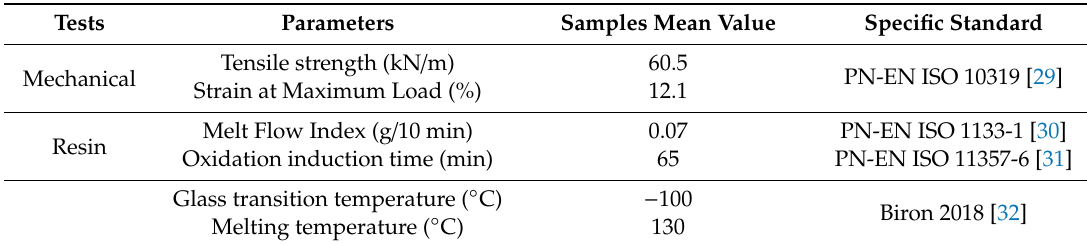
Table 1. The main engineering properties of the uniaxial geogrid.